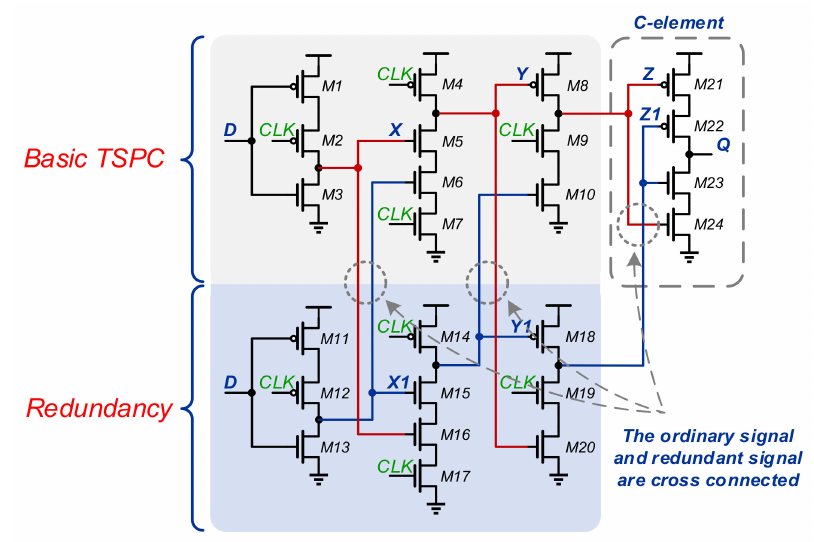
Figure 18. Schematic diagram of